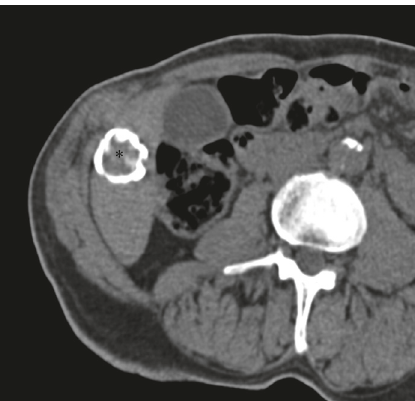
Figure 1: Axial unenhanced CT-scan performed a few years before the superinfection shows the hepatic hydatid cyst (asterisk) with calcified wall in segment